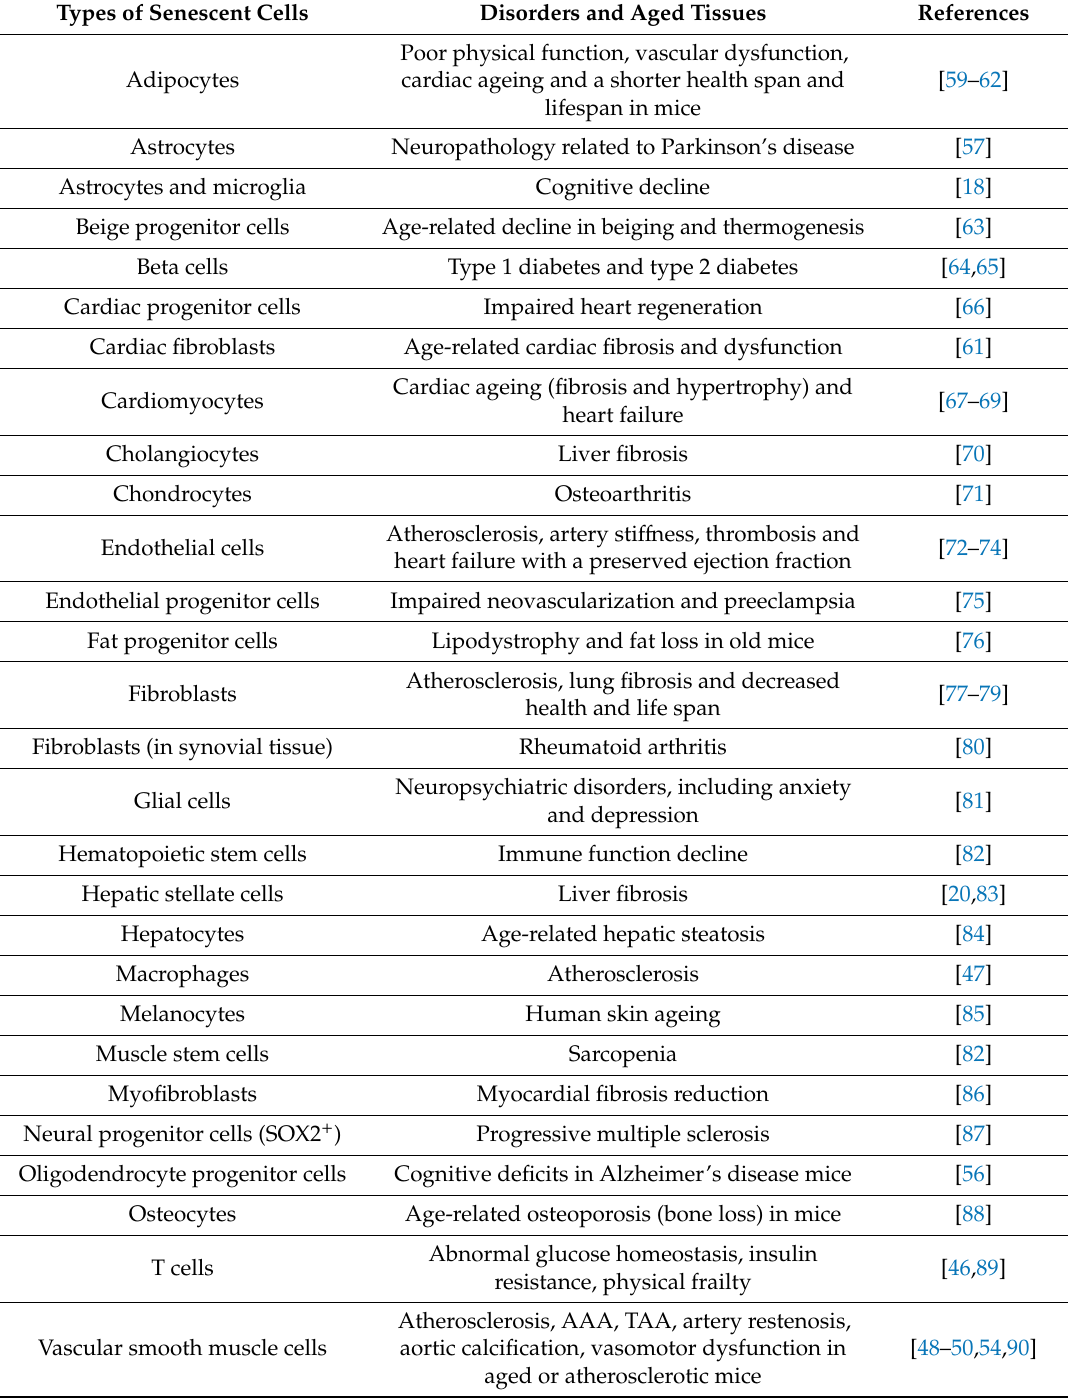
Table 1. Cellular senescence leads to chronic diseases or tissue ageing in animals and